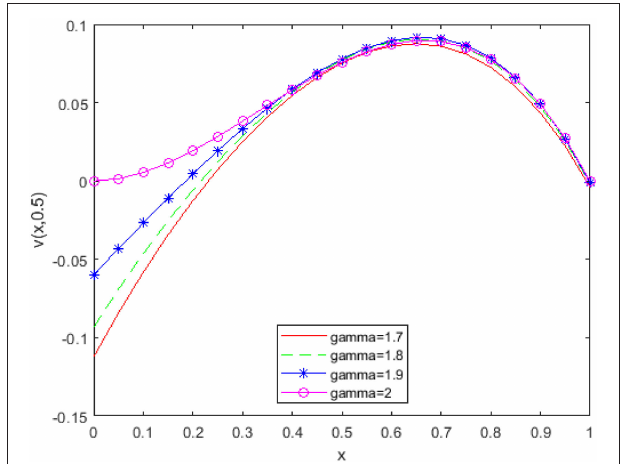
FIGURE 6 | Absolute errors at n = 3 and γ = 2.